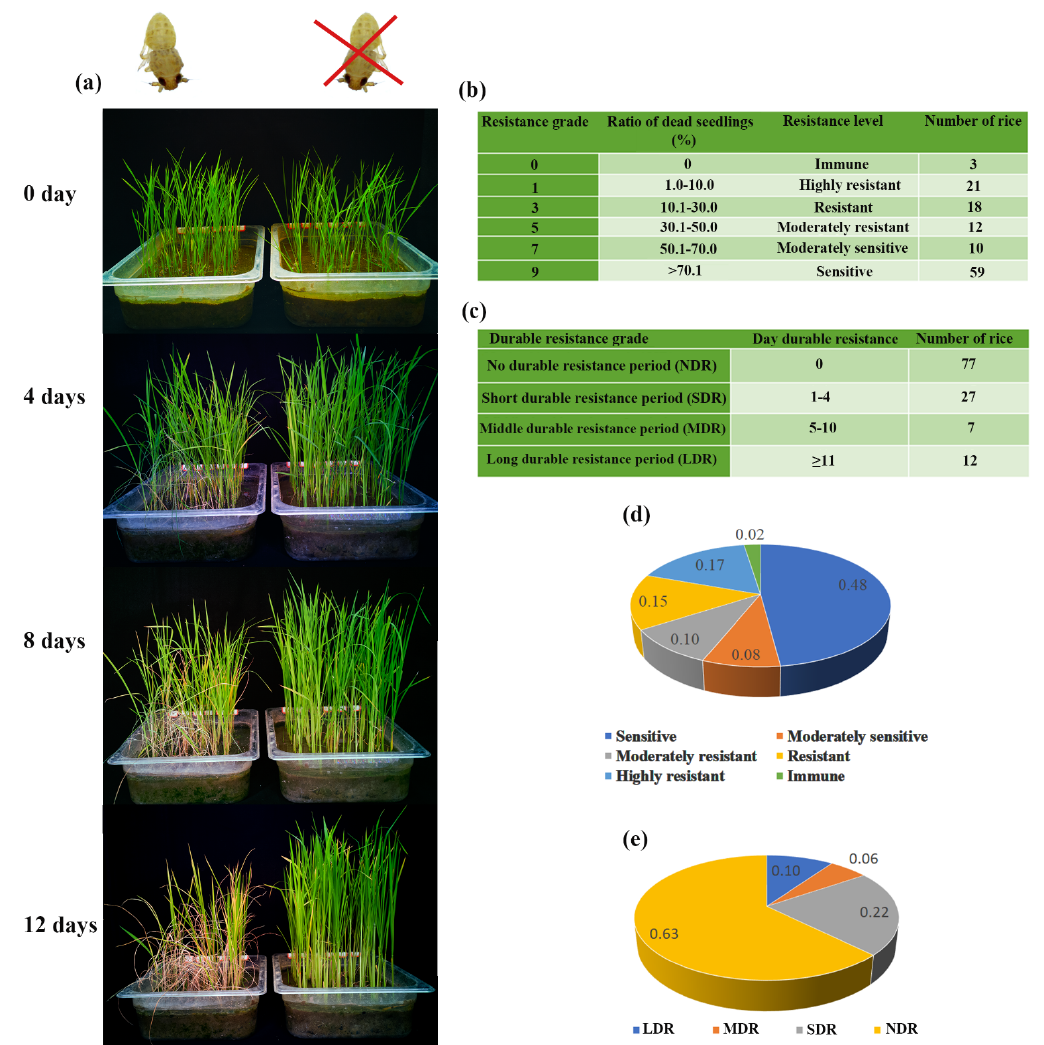
Figure 1. Phenotype identification of rice seedling resistance. ( a ) The phenotypic changes in TN1 rice (sensitive) seedlings inoculated with BPH nymphs after 0, 4, 8, and 12 days (the left tray); the right tray was treated without nymphs as a control. ( b ) Grading of rice seedling resistance to BPH. ( c ) Grading of the rice seedling durable resistance period for BPH. ( d ) Ratios of each resistance grade. ( e ) Ratios of each durable resistance grade.